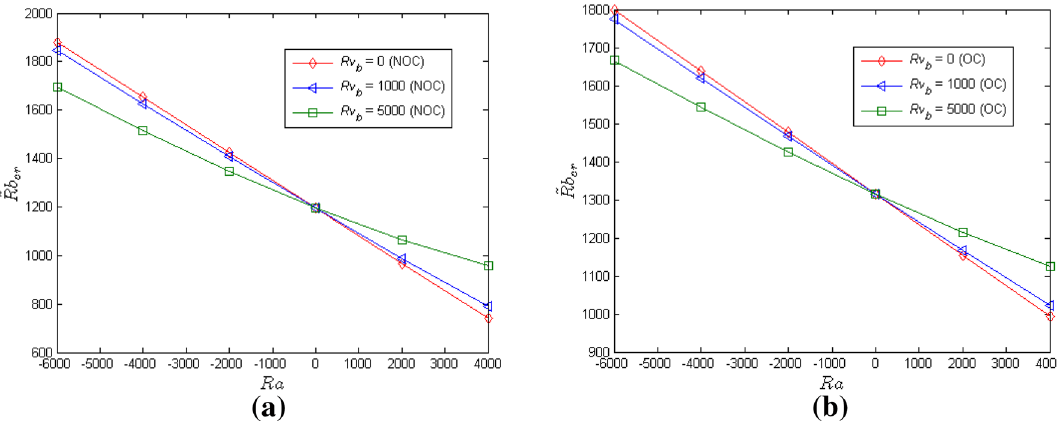
Fig. 8 The case of rigid lower and stress free upper surfaces: a , b Boundaries of stationary and oscillatory modes of convections in the ̃ Rb ( Ra , cr ) plane for the various values of thermo–vibrational parameter